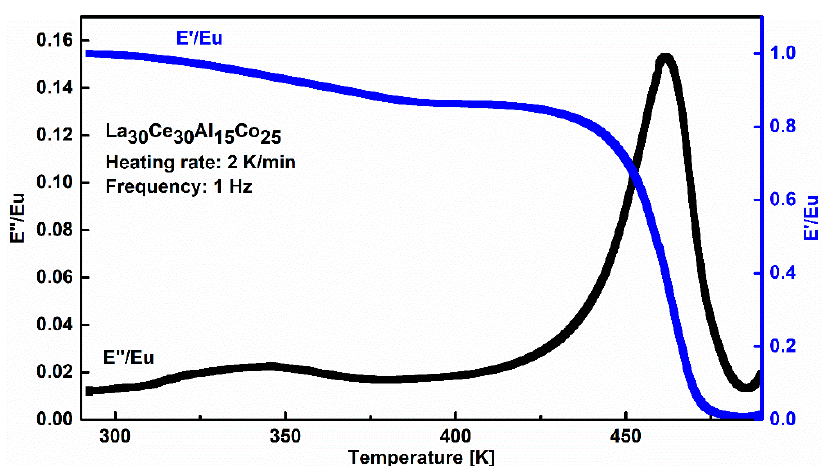
Figure 3. Evolution of the normalized storage modulus and loss modulus with temperature of La 30 Ce 30 Al 15 Co 25 metallic glass (the driving frequency is 1 Hz and the heating rate is 2 K/min). Eu is the unrelaxed modulus, which is assumed as the storage modulus at an ambient temperature.